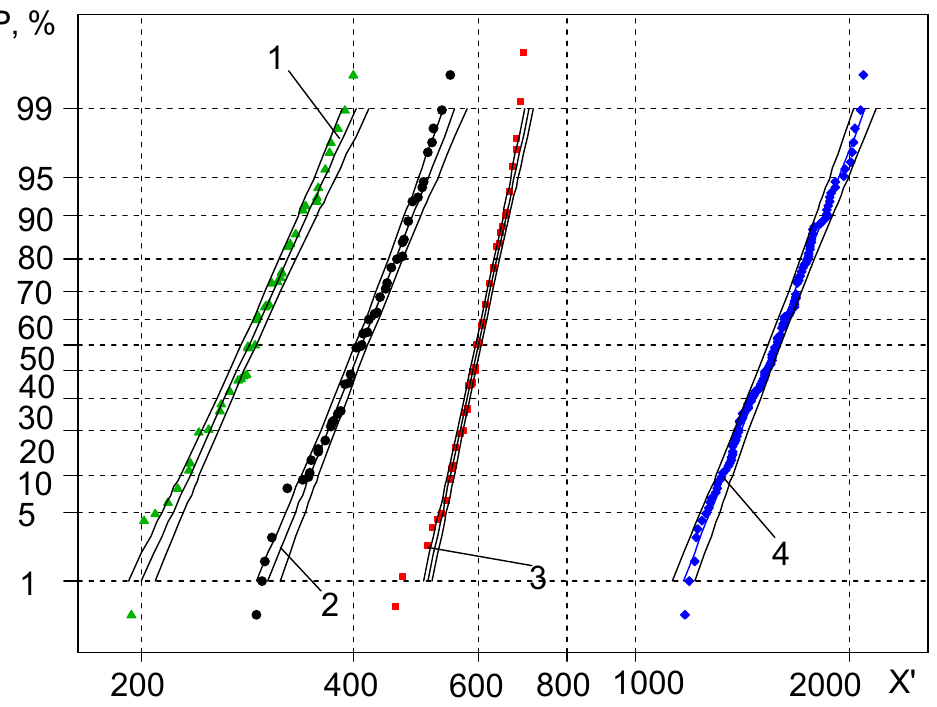
Figure 9. Statistical distribution curves for the mechanical properties of steel 15Cr2MoVA without adjusting for the sensitivity thresholds N 0 and N k (1— σ y , 2— σ pr , 3— σ u , 4— S k ).